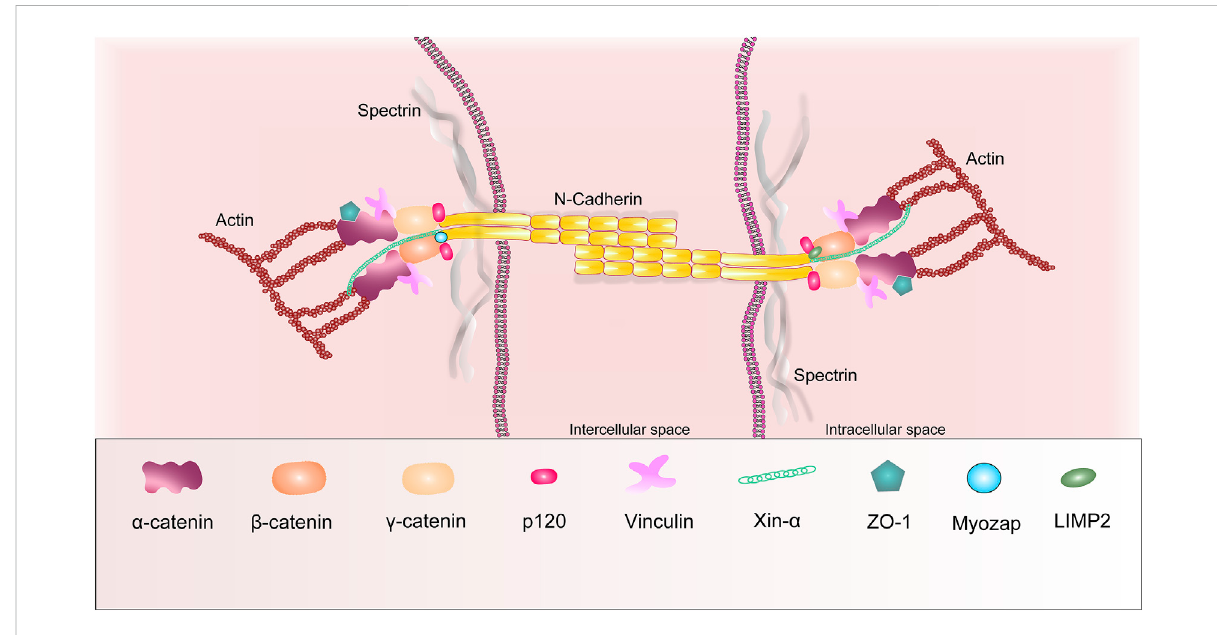
FIGURE 3 Schematic representation of the basic structural components of the adherens